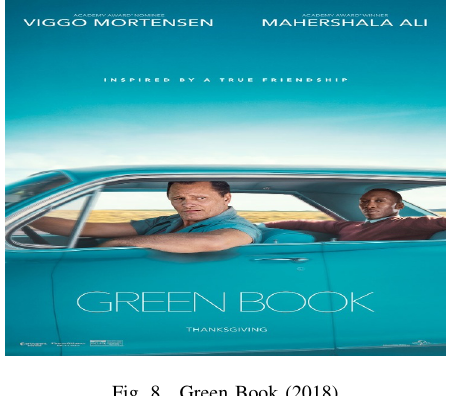
Fig. 8. Green Book (2018)